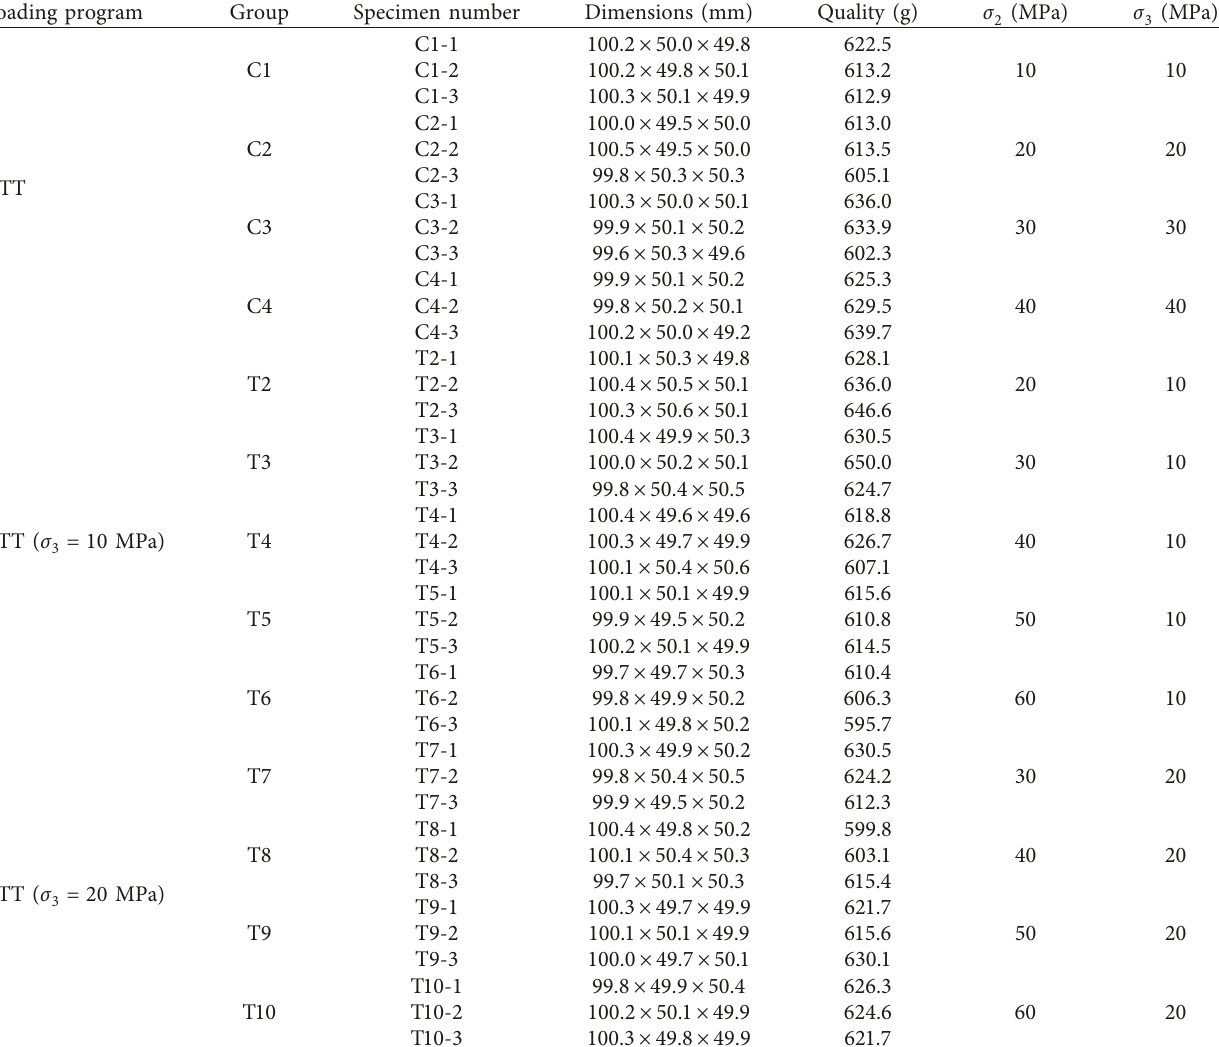
Table 1: Tested sandstone specimens and conditions in this research. Loading